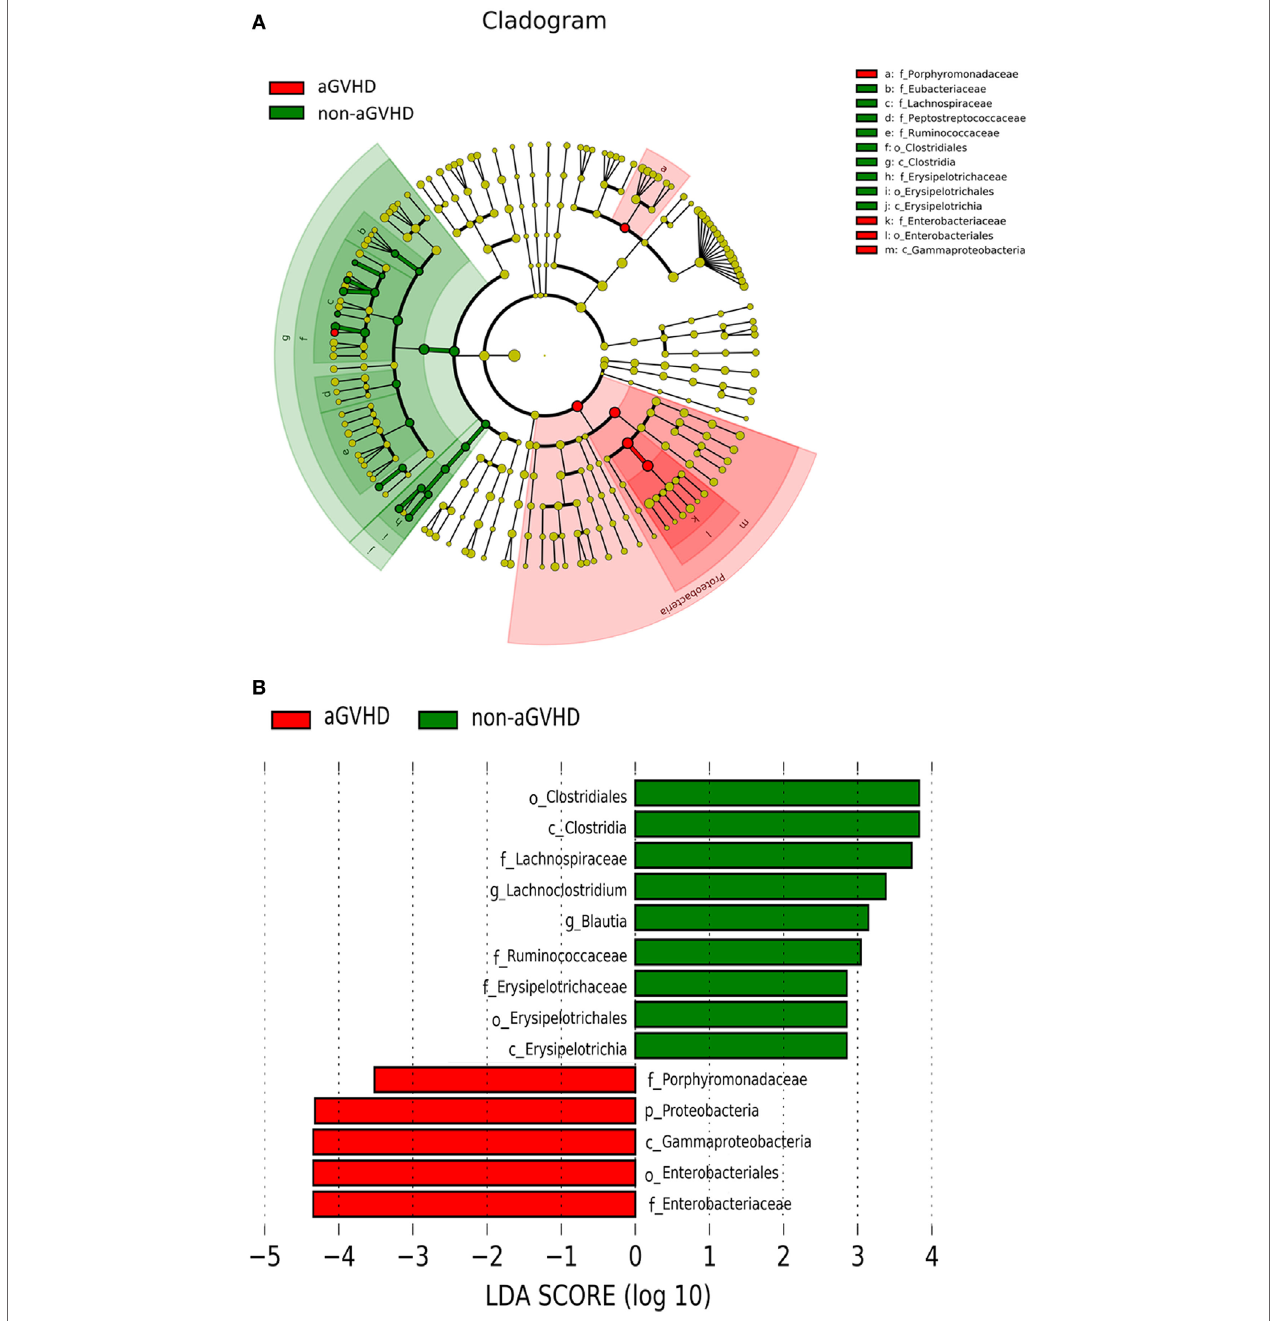
FigUre 3 | Differences of intestinal microbiota at engraftment between acute graft-versus-host disease (aGVHD) and non-aGVHD patients. (a) The taxonomic cladogram was generated using linear discriminate analysis (LDA) effect size (LEfSe) analysis between the groups. All listed microbiota groups are significantly different ( p < 0.05, Kruskal–Wallis test). (B) The histogram shown is an additional representation of analysis by the LEfSe method. All listed microbiota groups are significantly different ( p < 0.05, Kruskal–Wallis test). Abbreviations: p, phylum; c, class; o, order; f, family; g,